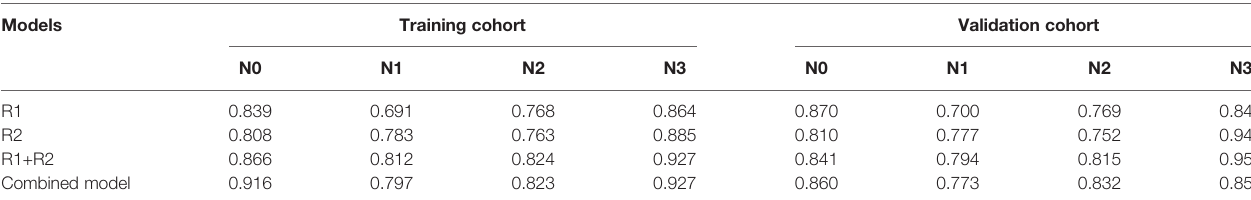
TABLE 3 | AUCs of radiomics models for evaluating lymph node staging. Models